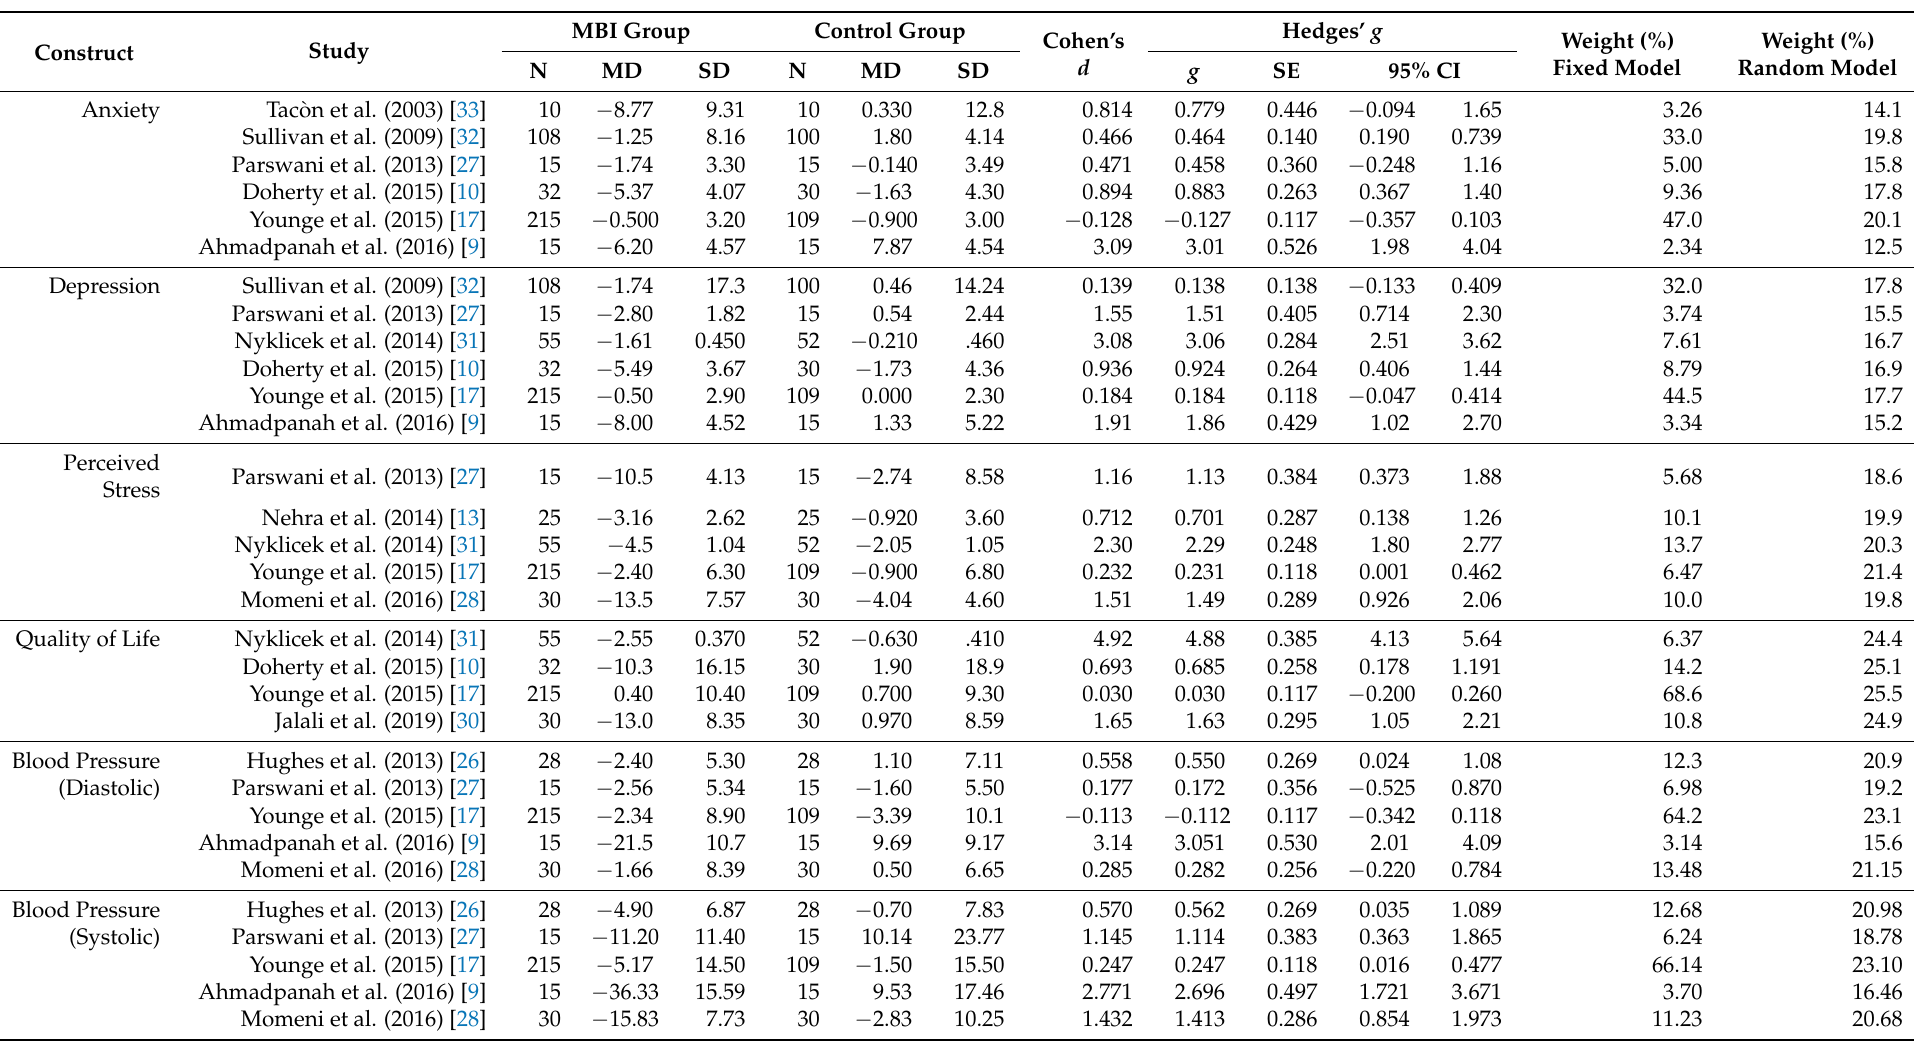
Table 3. Statistical results for studies included in the